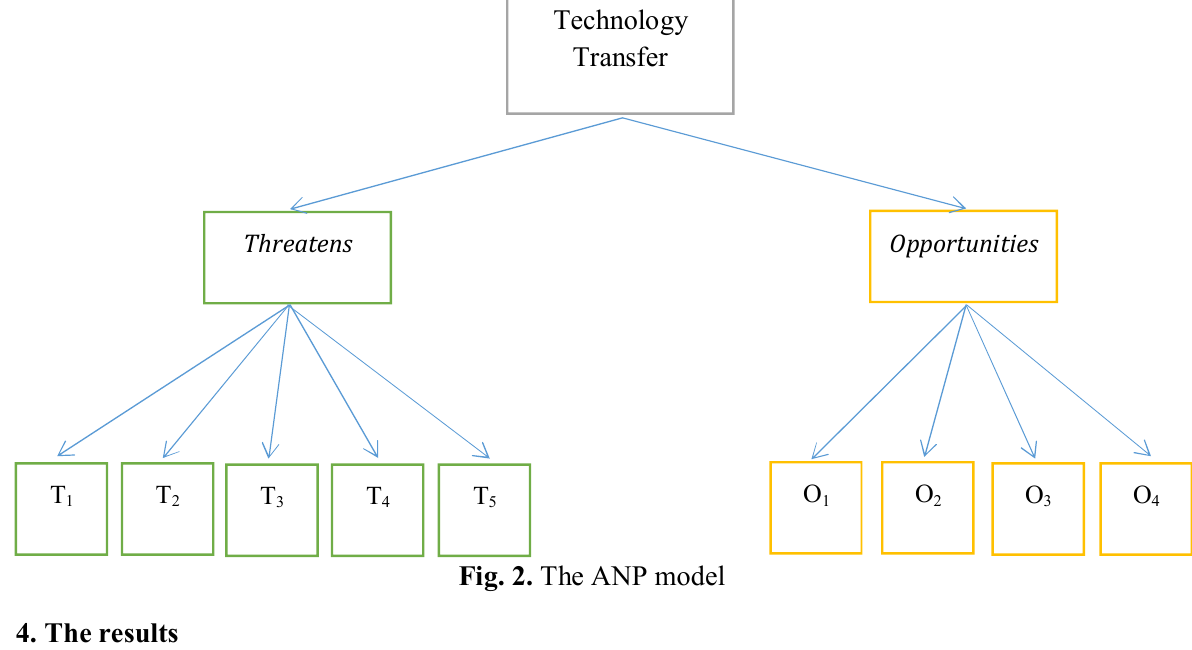
Fig. 2. The ANP model